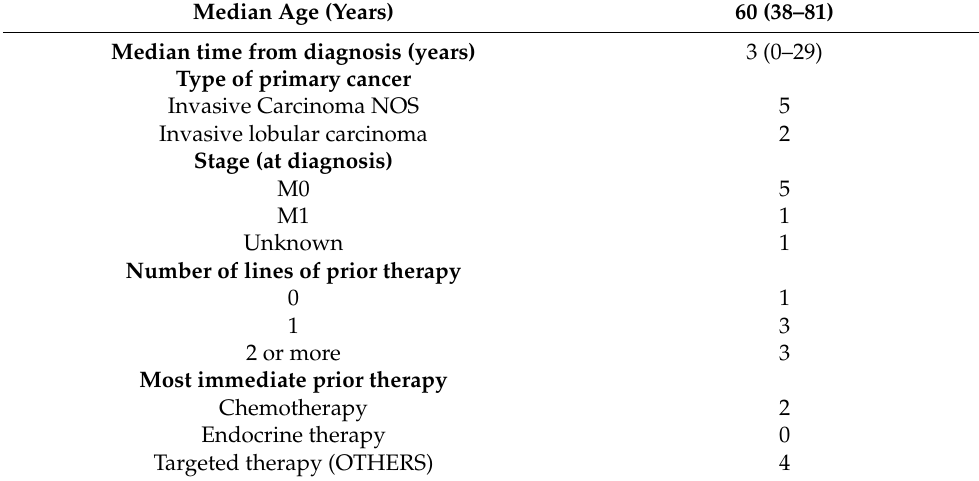
Table 1. Patient